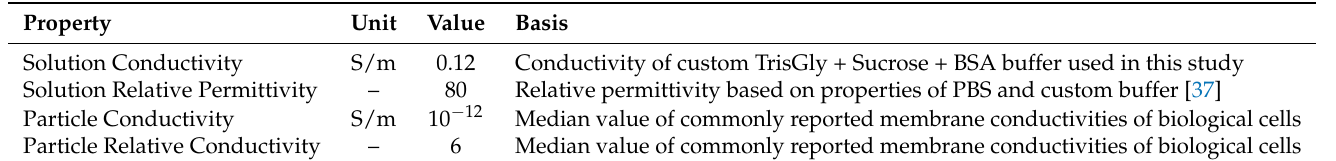
Table A1. Dielectric material properties used in the computational model of the reported device.